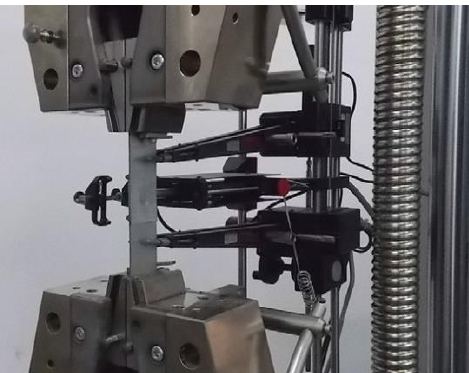
Figure 6. The extensometer ’ s measuring system used in tensile shear tests.